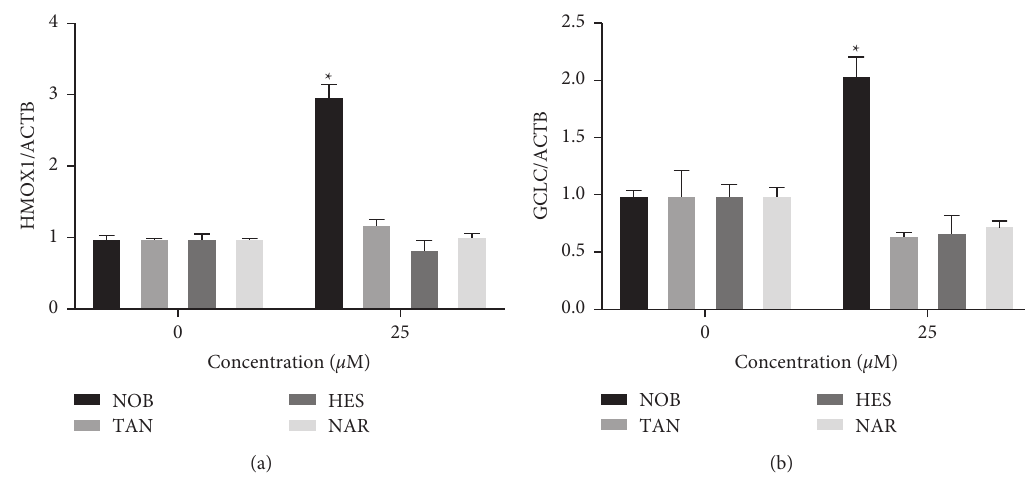
Figure 3: Effect of nobiletin (NOB), tangeretin (TAN), hesperetin (HES), and naringenin (NAR) on HMOX1 (a) and GCLC (b) mRNA levels after 18 h incubation. Data are presented as mean ± SD. ∗ indicates significant differences between the treatment group and untreated control group at p < 0 . 05.